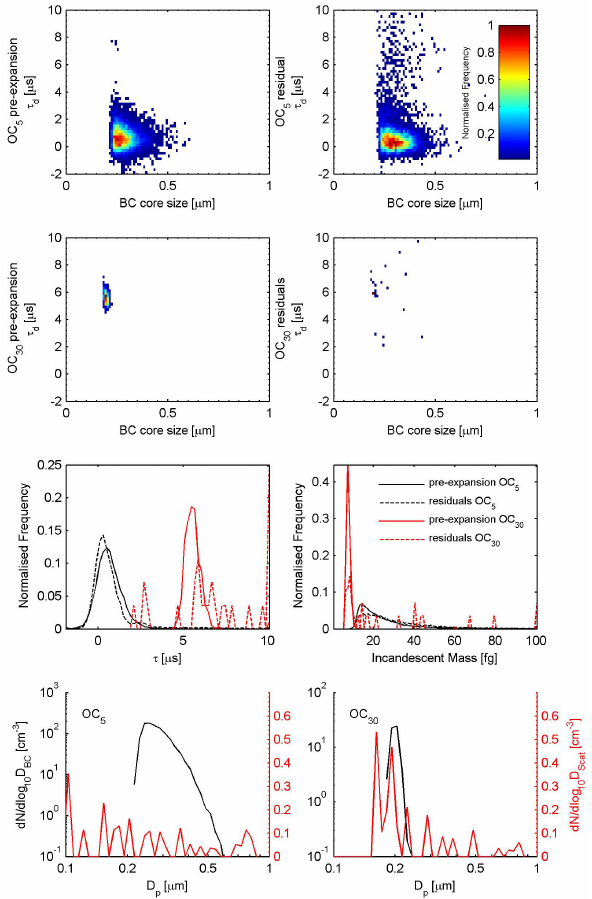
Fig. 5. Characterisation of Soot Core Size and Coating Thickness of the OC 5 and OC 30 flame soot. Top panels display the normailized frequency of soot as a function of BC core diameter and τ d for the OC 5 soot sampled at equilibrium in the AIDA chamber prior to a cloud expansion (left) and cloud particle residuals sampled during a cloud expansion using a PCVI (right). The frequency is normailized to the maximum observed frequency in the averaged sample. 2nd row panels display the same for the OC 30 soot. 3rd row panels dis- play the τ d probability density (left) and incandescent mass prob- ability density (right) at all BC score sizes for the OC 5 and OC 30 soot sampled pre-expansion at equilibrium and from PCVI residu- als. Bottom panels display the optical size distributions of the pre- expansion OC 5 (left) and OC 30 (right) soot; black line is for BC containing particles (left axis) and the red line is for purely scatter- ing particles only (right axis). Note different scales. The frequency of τ d and incandescent mass are normalized by sample